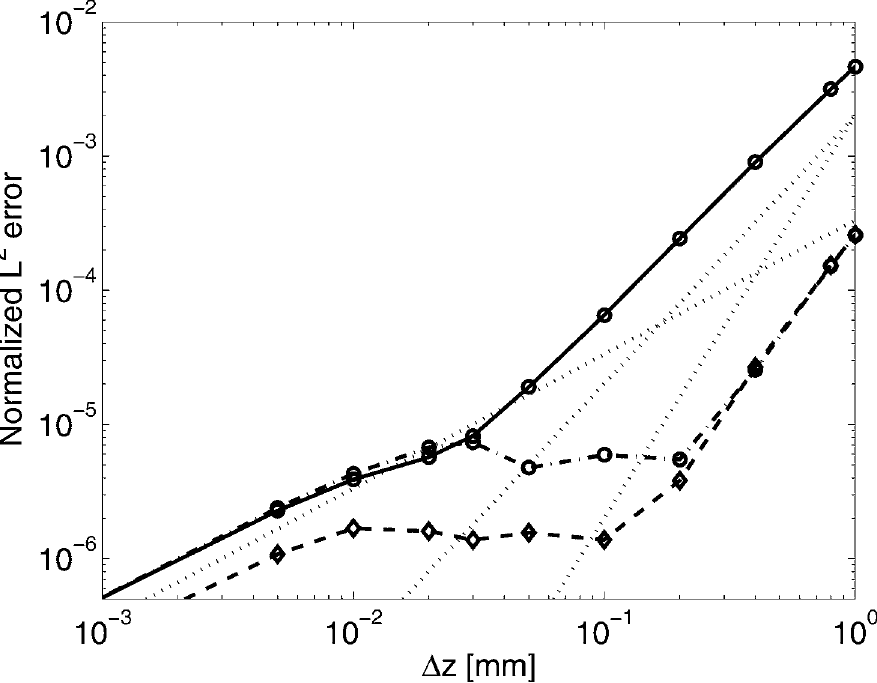
Figure 1. Relative local L 2 error for the numerical solution when compared to an analytic solution to Burgers’ equation. Solid line: Gudonov splitting. Dash-dot line: Strang splitting. Dashed line: Strang splitting with more accurate solution operators. Dotted lines: slopes for local first-, second- and third-order schemes.